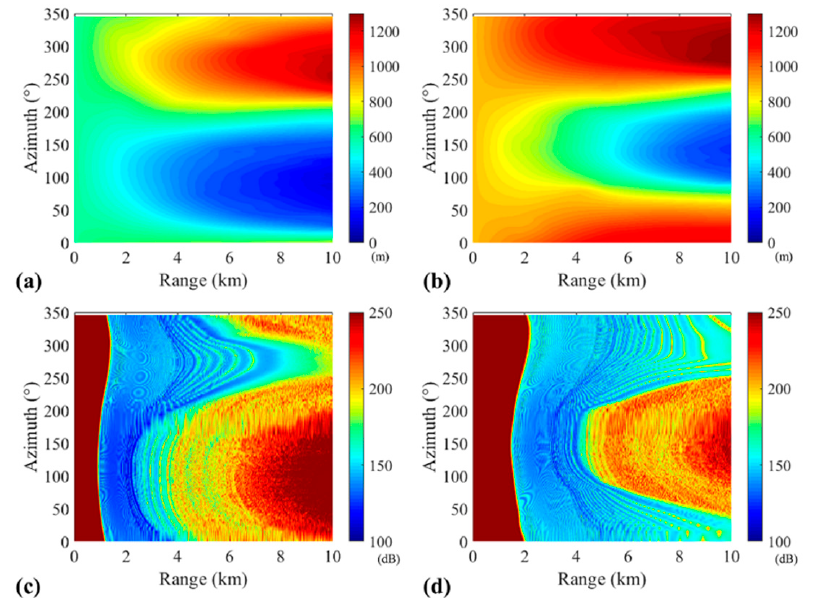
Figure 8. ( a ) Bathymetry map at the ship position for ping 97. ( b ) Bathymetry map at the ship position for ping 144. ( c ) Two-way transmission loss between source, receiver, and bottom cells ranging from the ship position for ping 97. ( d ) Two-way transmission loss between source, receiver, and bottom cells ranging from the ship position for ping 144. The colorbar represents the bathymetry depth in ( a , b ) and the two-way transmission loss in ( c , d ).